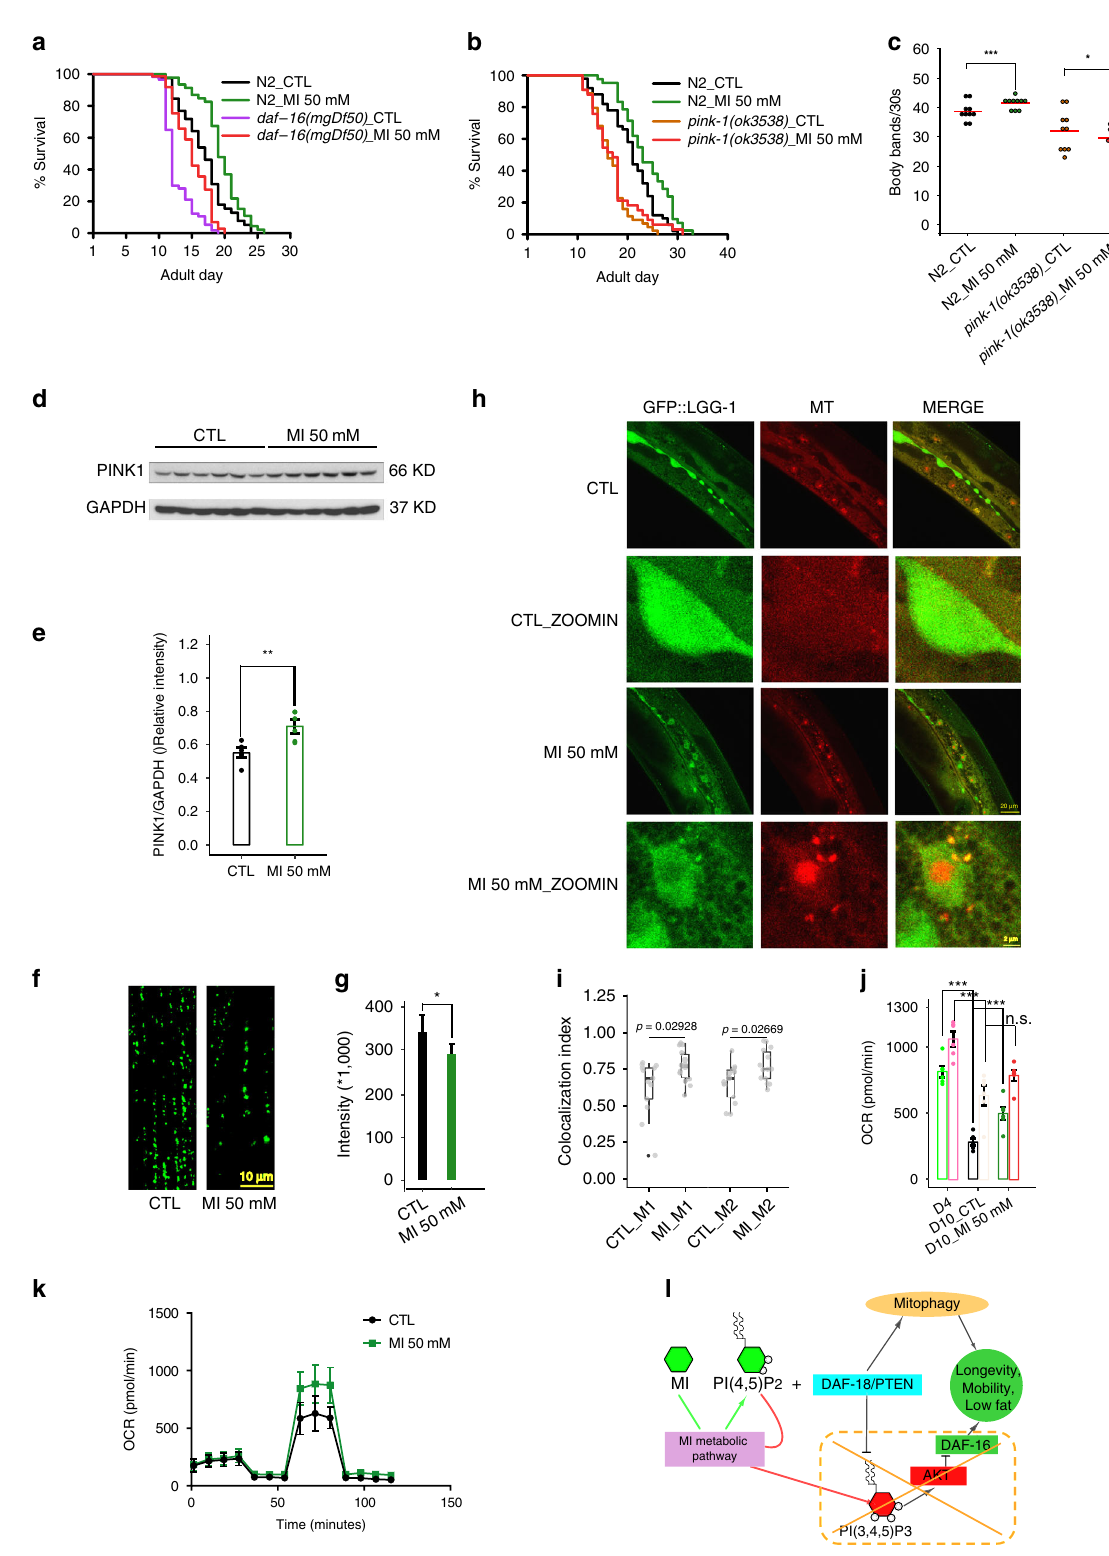
with Trizol reagent. All RNA samples passed the quality control of RIN>8 and 18S/ 28S>1.0. Sequencing was implemented with Illumina HiSeq 2000 system.